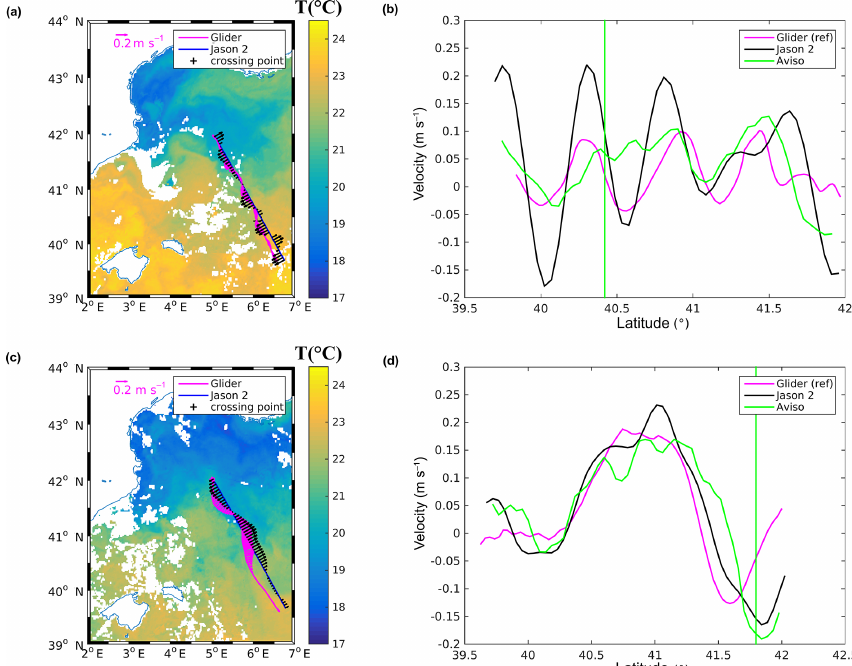
Figure 6. (a) Co-located Jason-2 track and currents (in black) and glider track and currents (in pink) for the southbound leg, overlaid with a satellite SST plot on 1 October 2012. (b) Along-track comparison of geostrophic velocities for the glider (including the drift velocities) in pink, and filtered along-track Jason-2 data in black. Mapped AVISO altimeter data, interpolated back onto the Jason-2 track, are in green. Green vertical line shows the position when the Jason-2 data and gliders are co-located in time. (c) – (d) Same but for the northbound section with SST fields from 21 October 2012; 48h SST fields at 0.02 ◦ resolution from